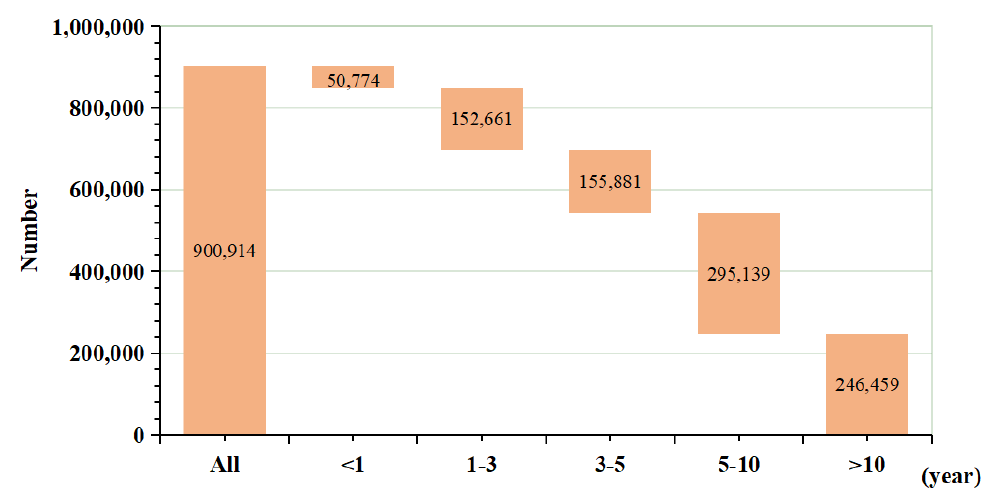
Figure 10. Social organizations categorized by the time of